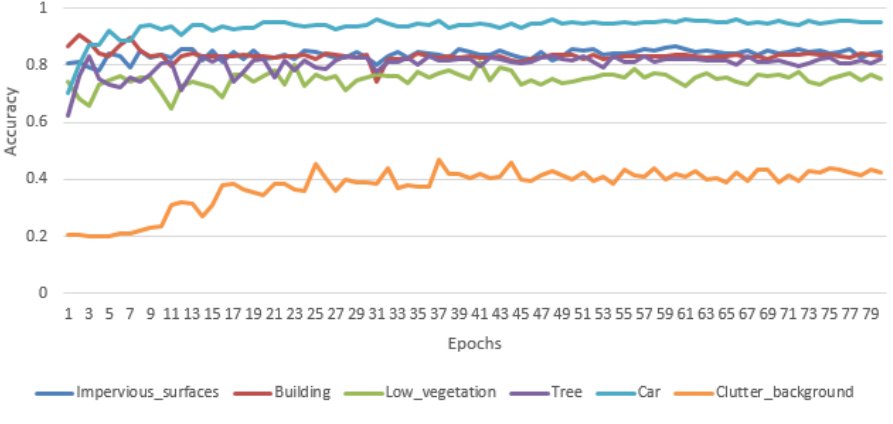
Figure 11. Evolution of per class accuracy of BiseNet trained on